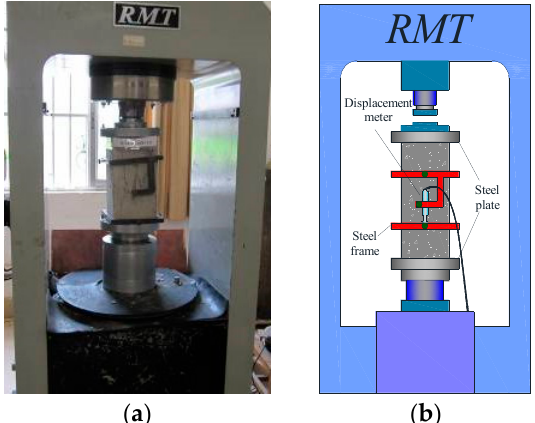
Figure 4. Test setup and measurement arrangement of block and column. ( a ) Test setup; ( b ) Measurement arrangement.